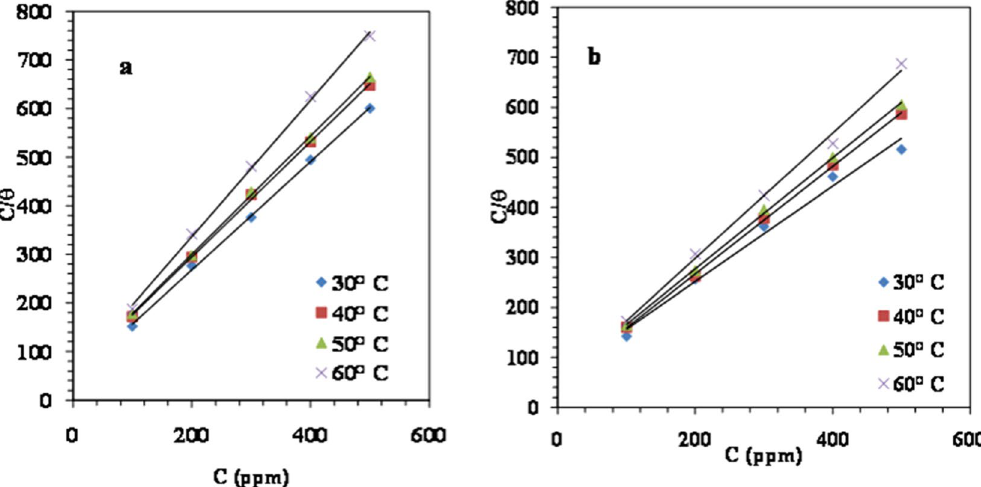
Figure 9. Langmuir adsorption isotherm plots for MS in 1M HCl solution containing various concentrations of ( a ) LPr ( b ) LPr + 10 ppm NaBenz at 30–60 °C.